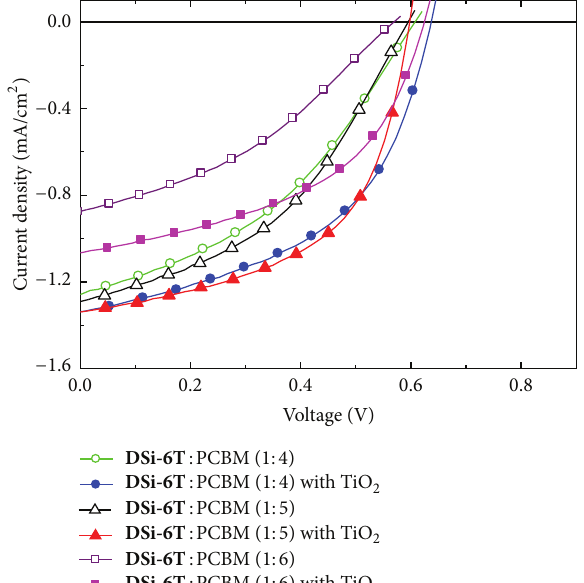
Figure 4: J-V characteristics of ITO/PEDOT: PSS/DSi-6T:PCBM/ Al (active layer DSi-6T :PCBM 1: 4, w/w ( I ), 1:5 w/w ( △ ), 1:6 w/w ( ◻ )) and ITO/PEDOT:PSS/DSi-6T :PCBM/TiO 2 /Al (active layer DSi-6T:PCBM 1: 4, w/w ( ∙ ), 1:5 w/w ( 󳵳 ), 1:6 w/w ( ◼ )) under illumination of AM 1.5, 100 mWcm −2 .